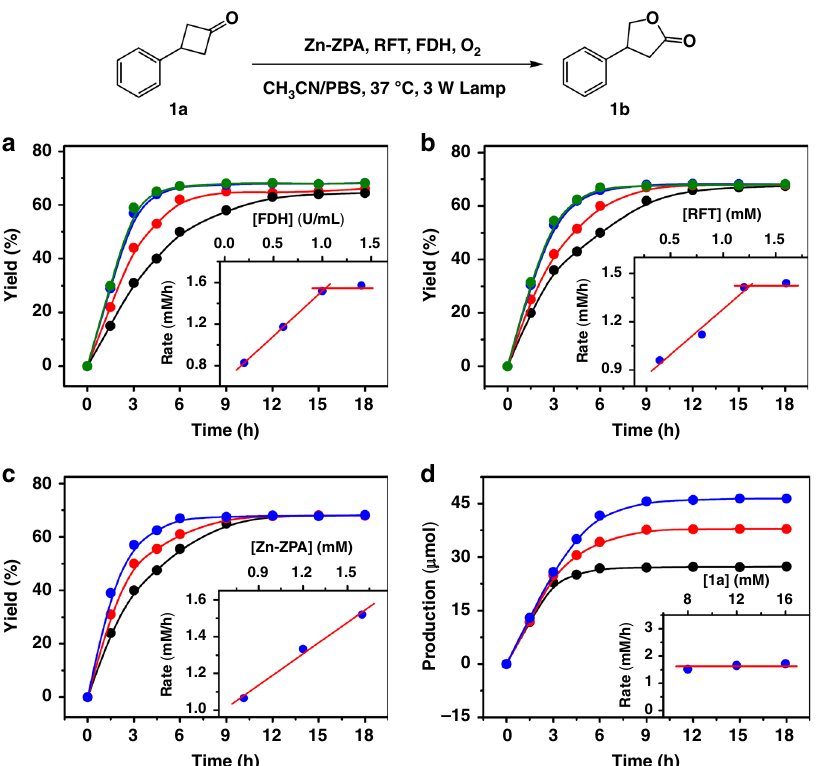
Fig. 5 Kinetics of the Baeyer – Villiger oxidation. a Yield of 1b as a function of the concentration of FDH with RFT (1.6 mM), Zn – ZPA (1.6 mM) and 1a (8.0 mM) remaining fi xed. b Yield of 1b as a function of the concentration of RFT with FDH (1 U mL − 1 ), Zn – ZPA (1.6 mM) and 1a (8.0 mM) remaining fi xed. c Yield of 1b as a function of the concentration of Zn – ZPA with FDH (1 U mL − 1 ), RFT (1.6 mM) and 1a (8.0 mM) remaining fi xed. d Yield of 1b as a function of the concentration of 1a with FDH (1 U mL − 1 ), Zn – ZPA (1.6 mM) and RFT (1.6 mM) remaining fi xed; the reaction contained HCOONa (16.0 mM) and